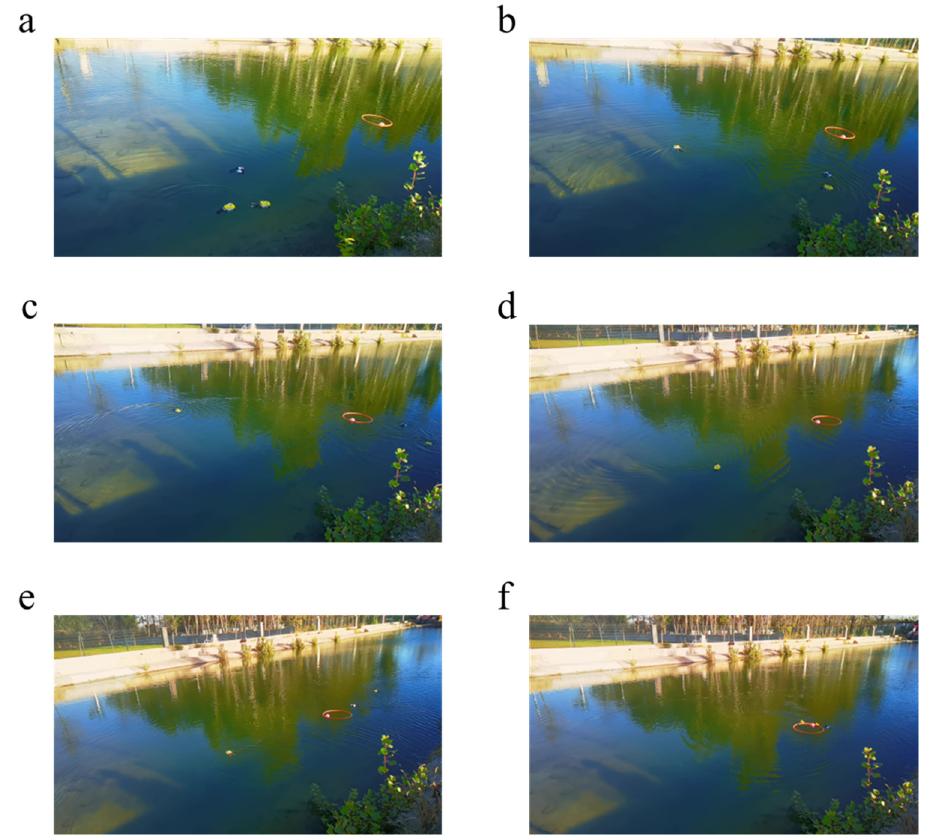
Figure 2. Swarm game for autonomous underwater robots (one target, three altruistic robots). This figure shows snapshots of our experiment over time. The time starts from the beginning of the experiment. Different panels correspond to different times: (a) t=0s; (b) t=15s; (c) t=30s; (d) t=45s; (e) t=60s; (f) t=83s.